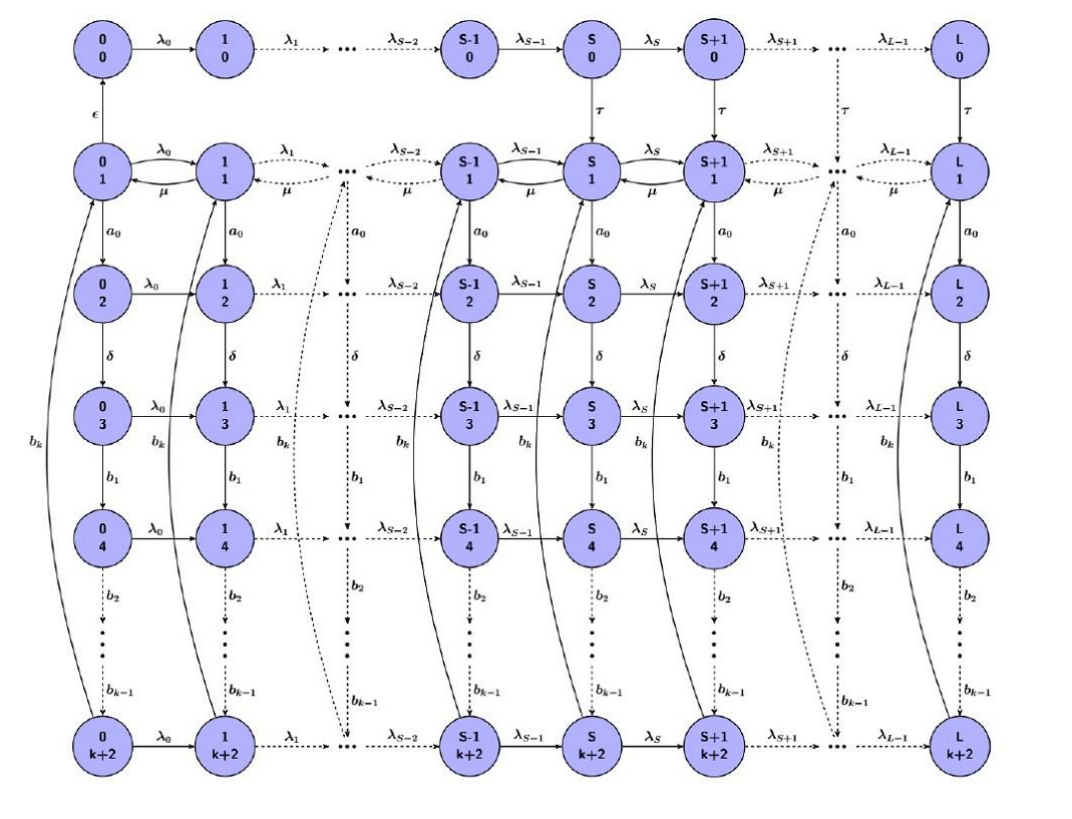
Figure 1. Transition state